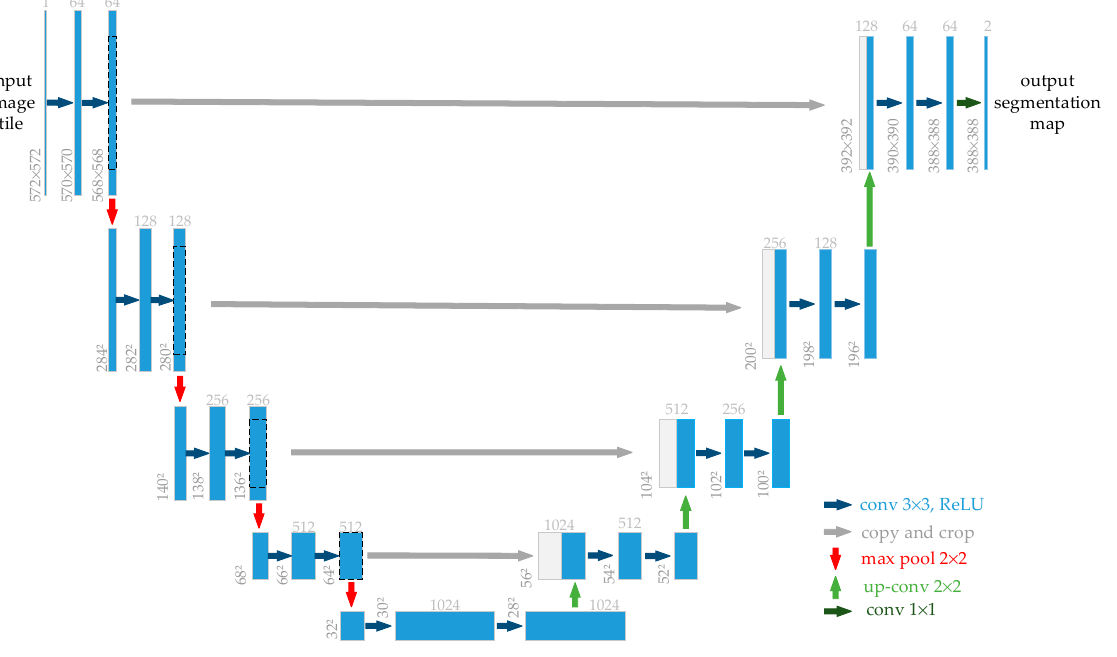
Figure 2. The original U-Net model [9] .